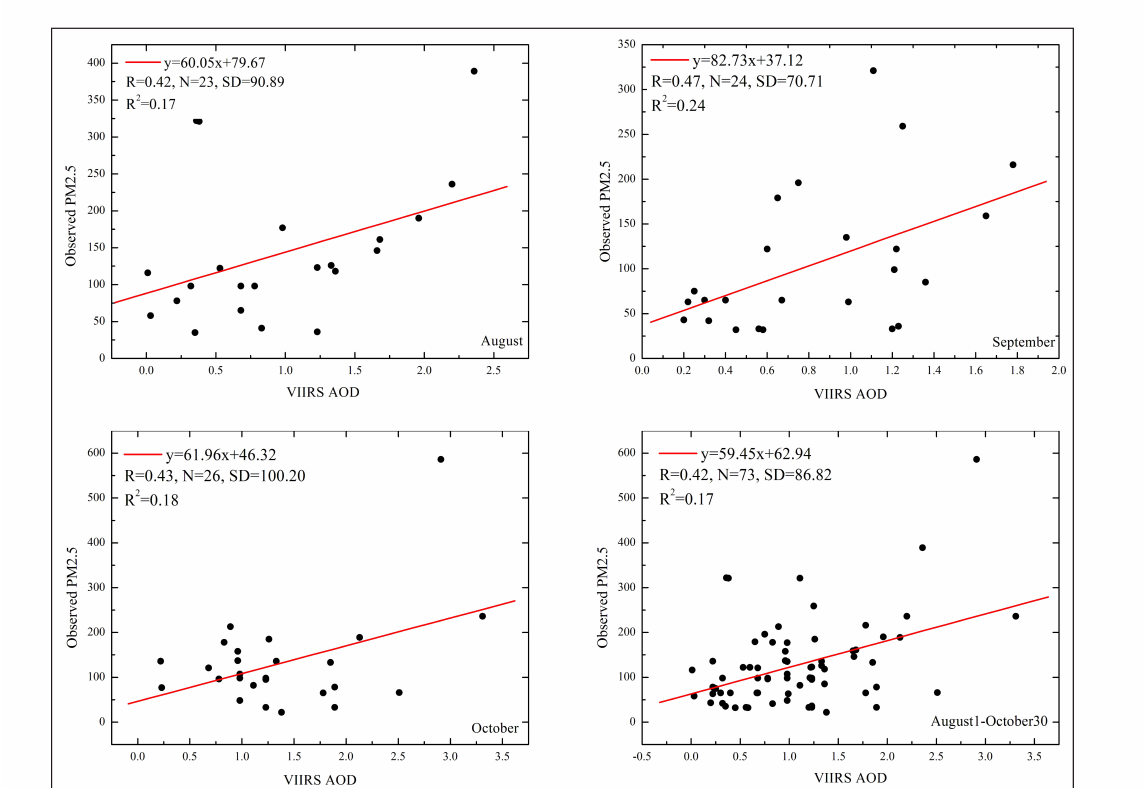
Figure 1. Scatter plots of VIIRS AOD vs. Observed PM2.5